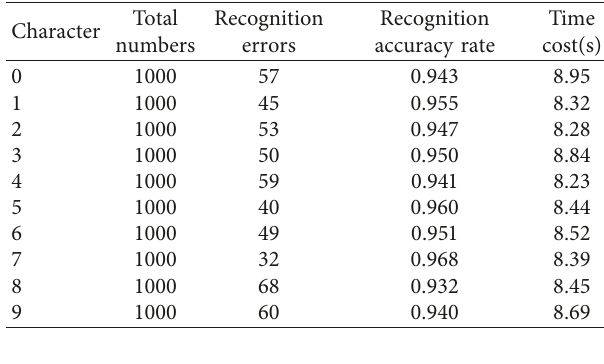
Table 2: Test results of TESSERACT.